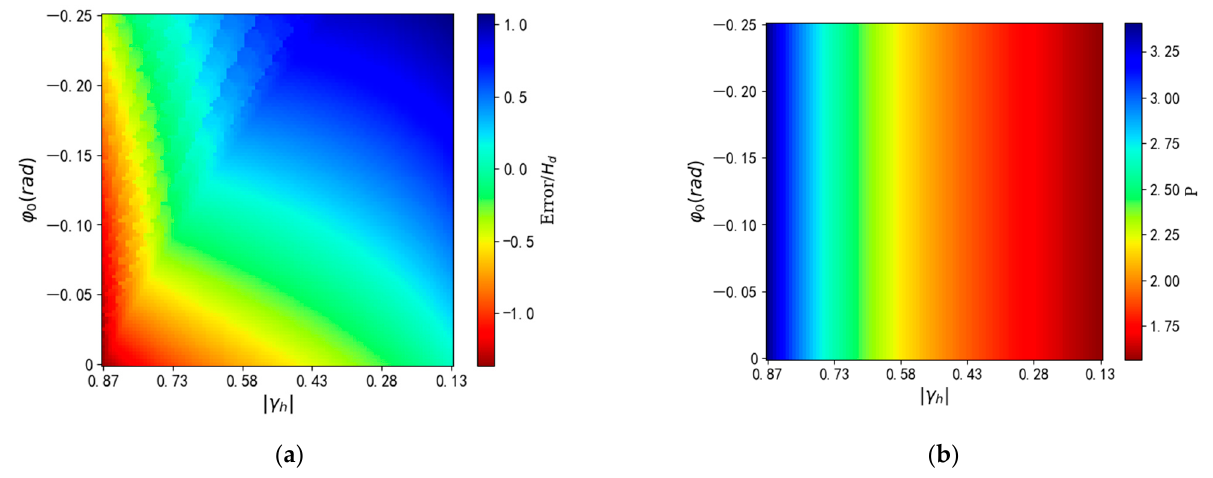
Figure 5. Plots showing ( a ) the simulation results of error variation relative to penetration depth and ( b ) simulation results of variations in the p -value relative to coherence amplitude. ( b ) simulation results of variations in the p -value relative to coherence